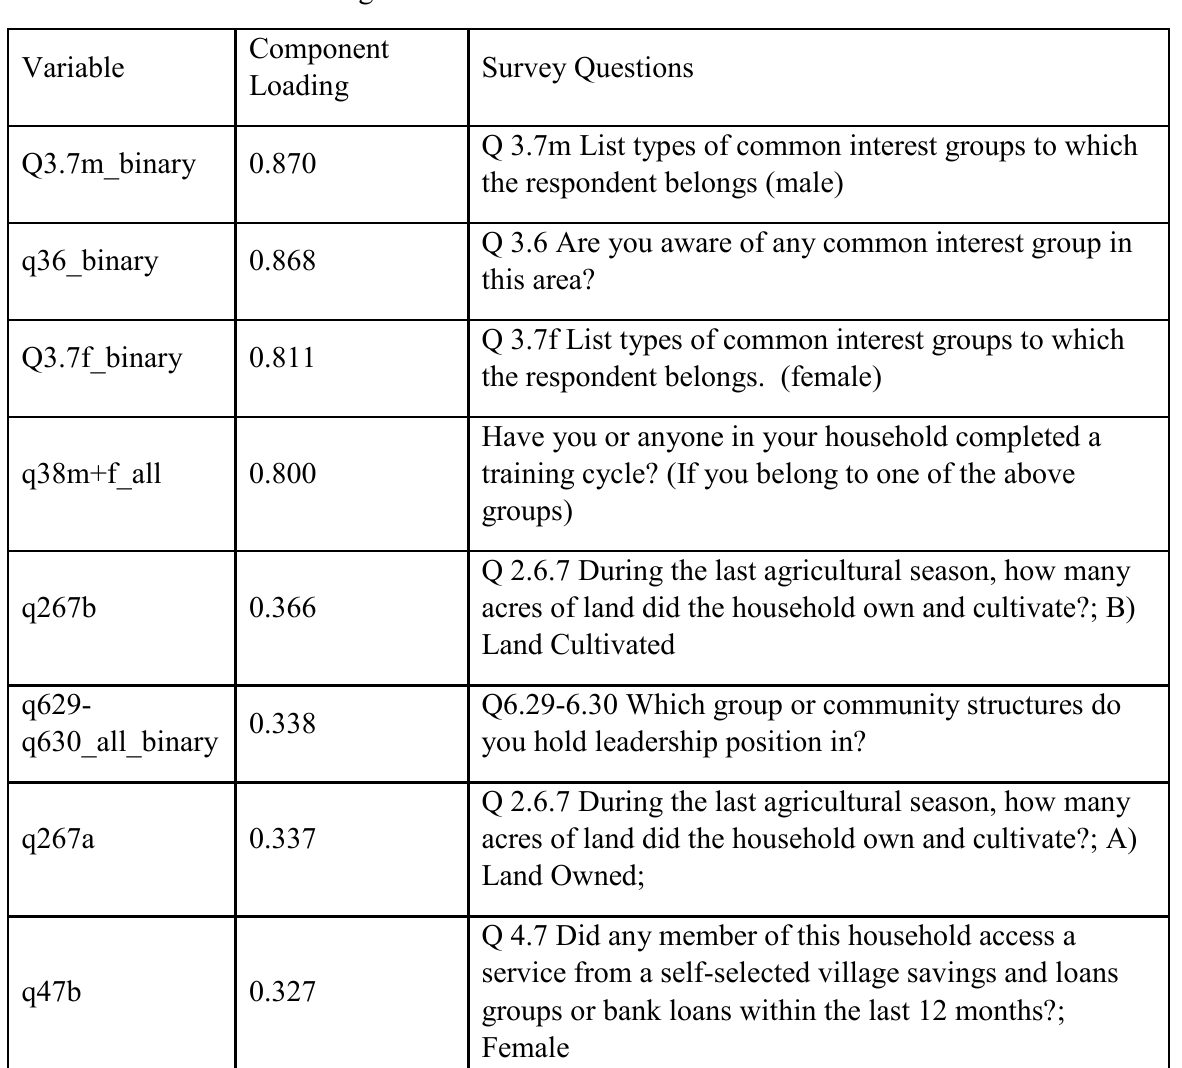
Table 1.42: Variables defining Transformative Resilience PC2